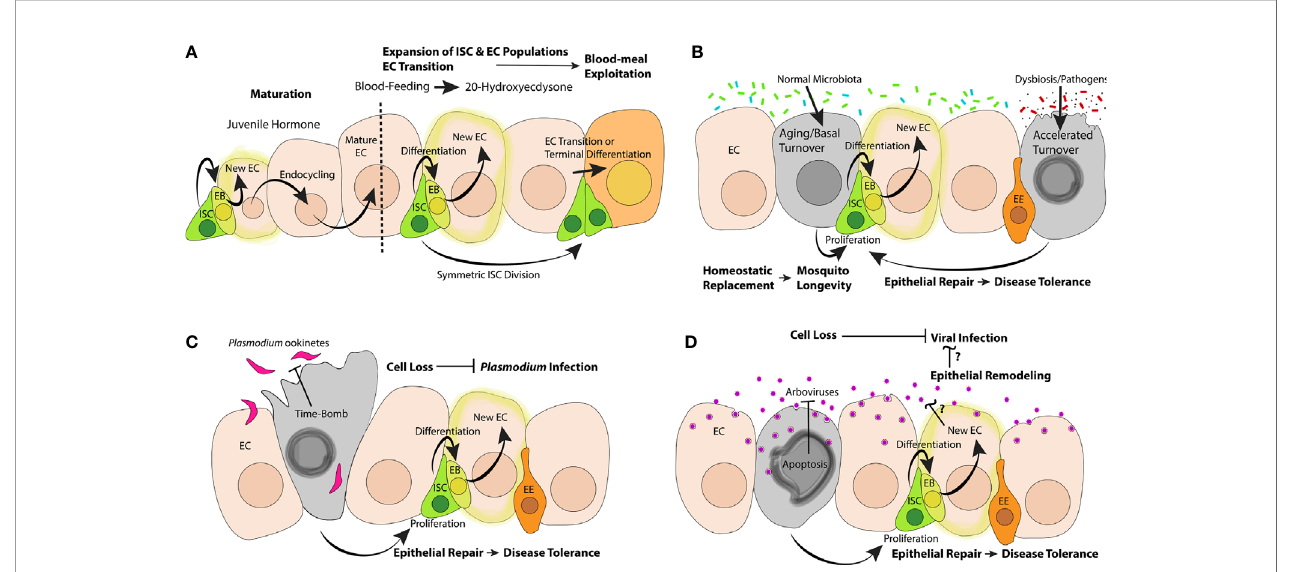
FIGURE 1 | Possible impacts of epithelial dynamics in the mosquito midgut on the hematophagous lifecycle, aging, interactions with gut fl ora, Plasmodium and arboviral infections. (A) During the post-emergence maturation, JH could stimulate ISCs to proliferate and create new ECs or prompt ECs to endocycle to attain higher ploidy; blood-feeding stimulates the production of 20E, which could stimulate the proliferation of ISCs, the differentiation of new ECs, and transcriptional changes in ECs. (B) Normal microbiota could contribute to aging and basal turnover of EC populations; dying ECs could stimulate ISCs to effect homeostatic replacement; dysbiosis and/or infection with oral bacterial pathogens could accelerate the turnover of epithelial cells; ISC-mediated repair could serve as a disease tolerance mechanism, promoting mosquito survival. Invasion by Plasmodium (C) and/or arboviral pathogens (D) could prompt cell sacri fi ce mechanisms to limit pathogenic success; ISC proliferation and differentiation could help infected mosquitoes to tolerate epithelial